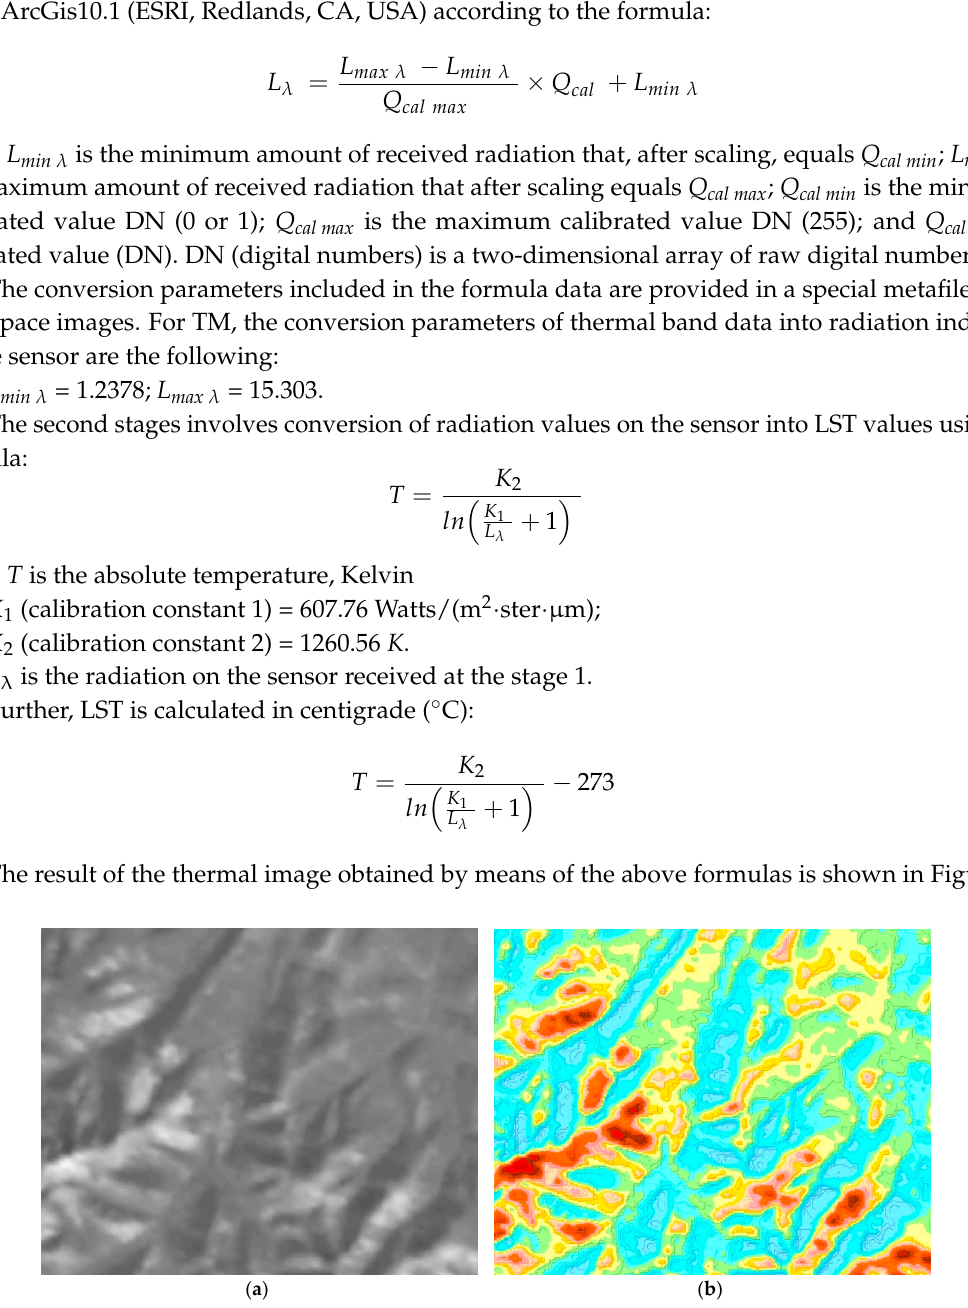
Figure 4. Converting Landsat TM data in values of temperature (on the example Elkon Massif). ( a ) Original space image of the thermal band of 6 (Landsat-5/TM); ( b ) The resulting image by converting the radiation values at the sensor to the values of the radiation temperature of the earth’s surface